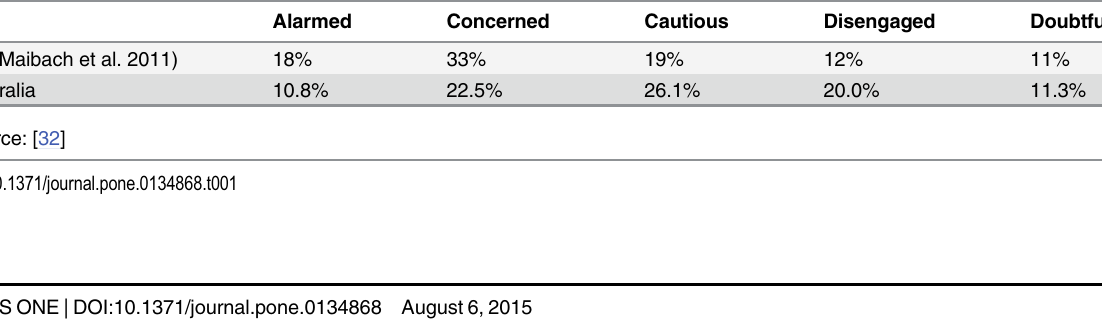
Table 1. Segment size in US versus